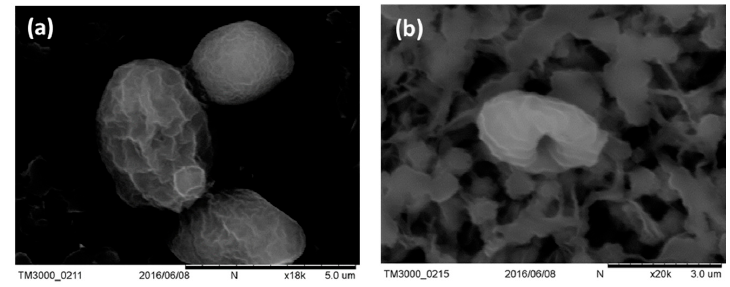
Figure 6. SEM images of C. albicans ( a ) before and ( b ) after PDT treatments.